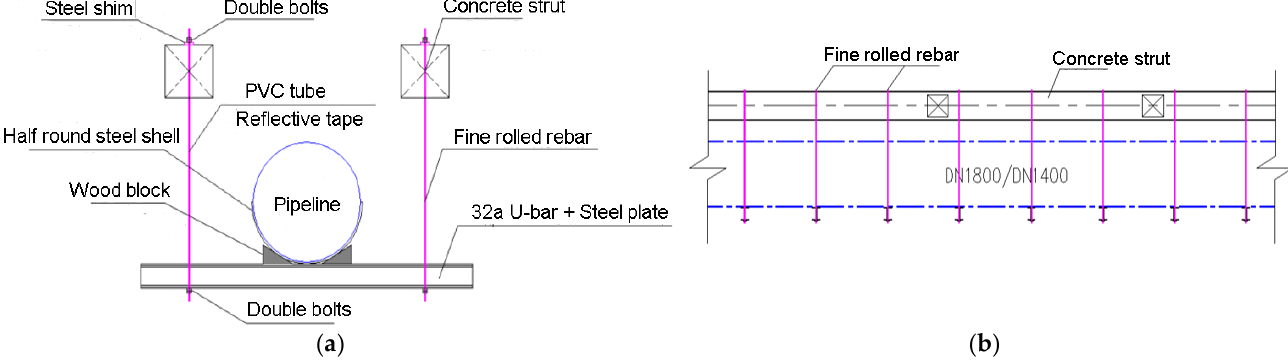
Figure 4. Schematic diagram of the pipeline suspension structure: ( a ) Transverse section; ( b ) Longi- tudinal section.